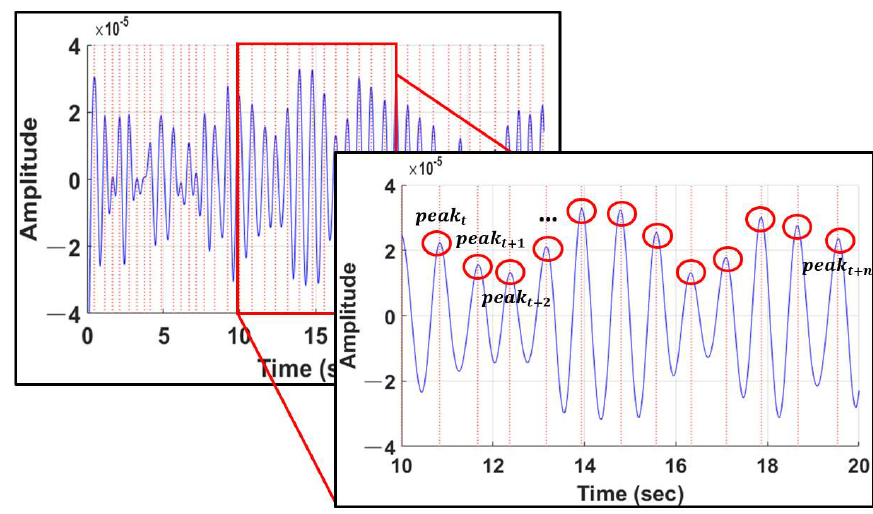
Figure 10. Peak detection of pulse waves.